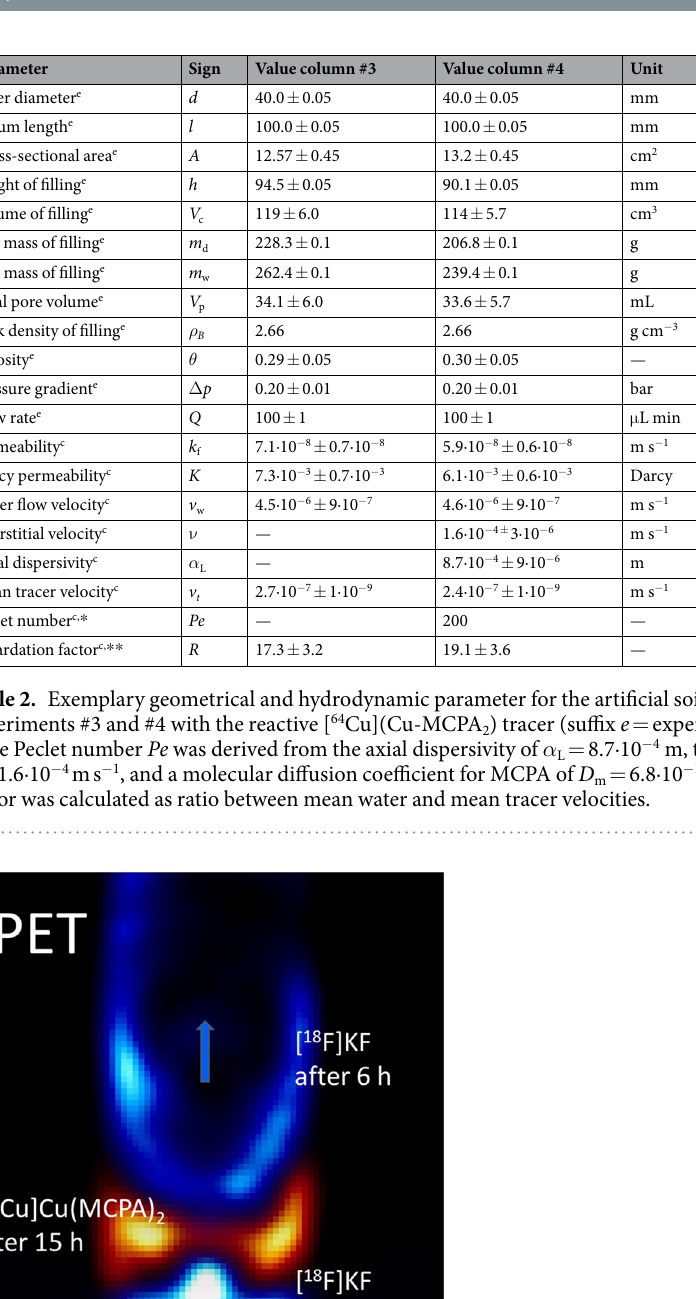
4 ScIENtIfIc RepoRts | (2018) 8:7091 | DOI:10.1038/s41598-018-25413-9